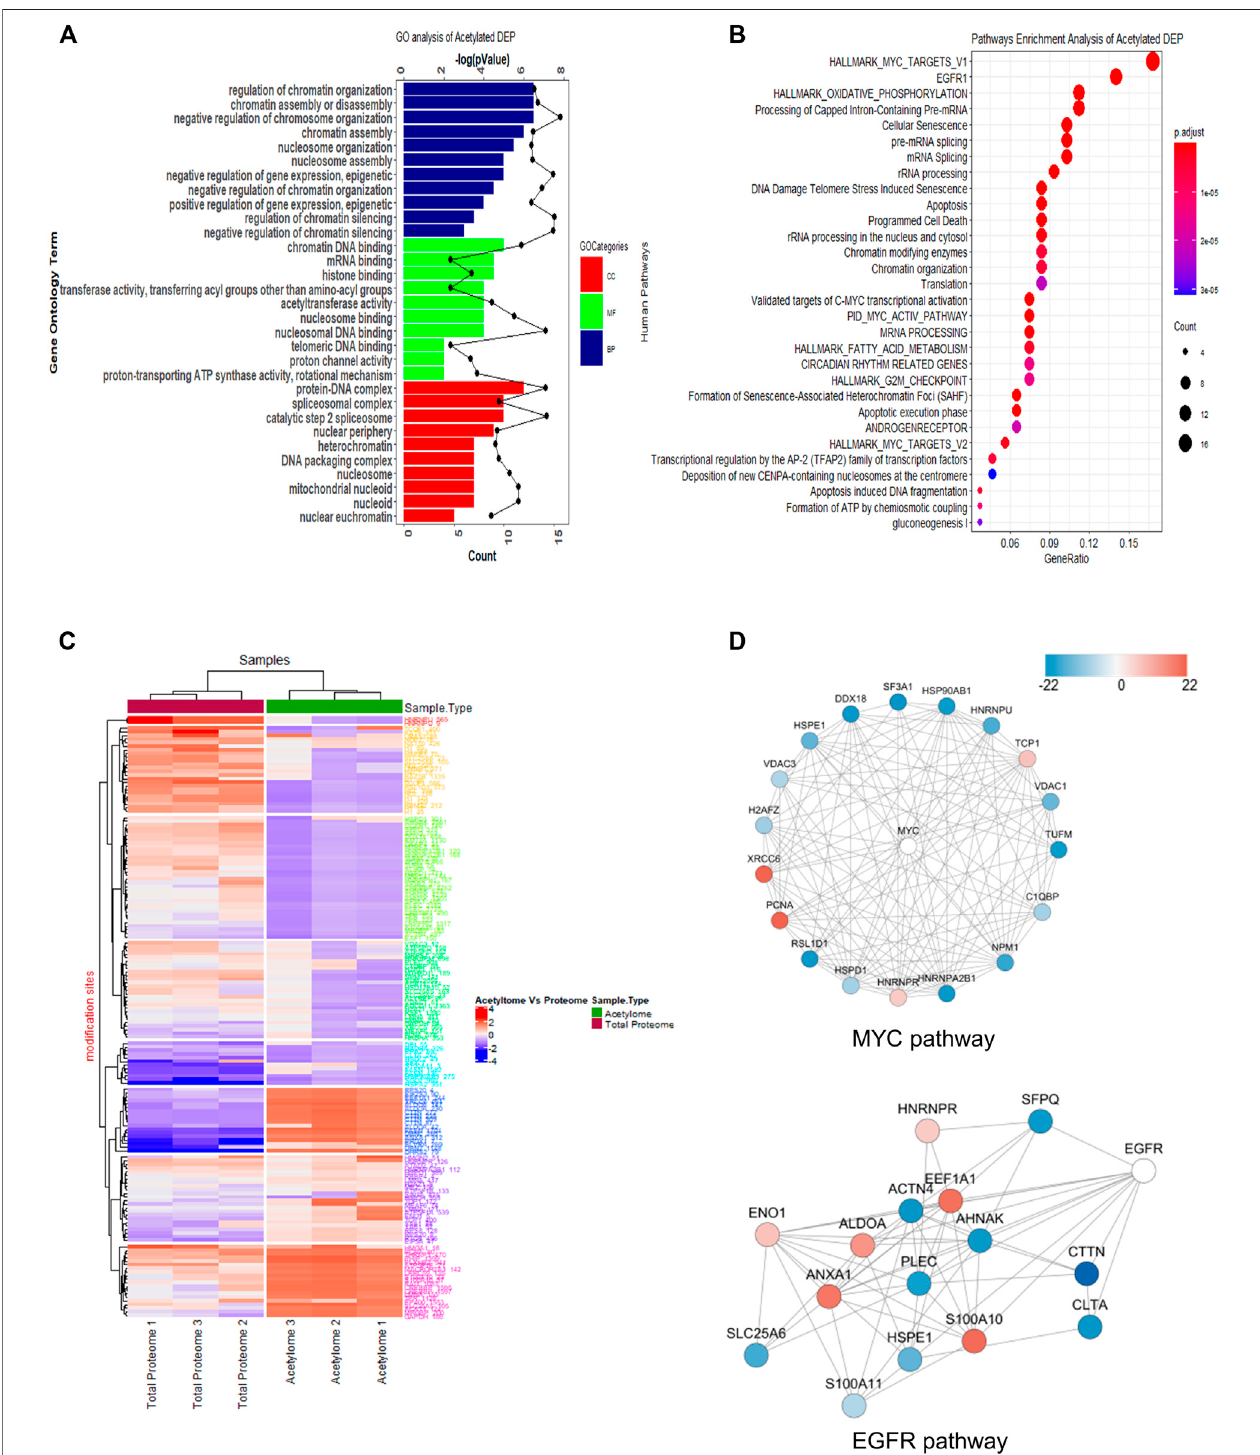
FIGURE 3 | Functional enrichment analysis of quanti fi ed acetylated proteins. (A) GO enrichment analysis. (B) KEGG pathway analysis. (C) Heatmap diagram of a two-way hierarchical clustering. The red and blue colors indicate the expression level of proteins in terms of normalized ratio. Upper color labeling shows total proteome samples in red and acetylome in green. The distance of hierarchical clustering was measured using the Euclidean method. (D) Protein – protein interaction network of acetylome clustered in the representative MYC and EGFR pathway.